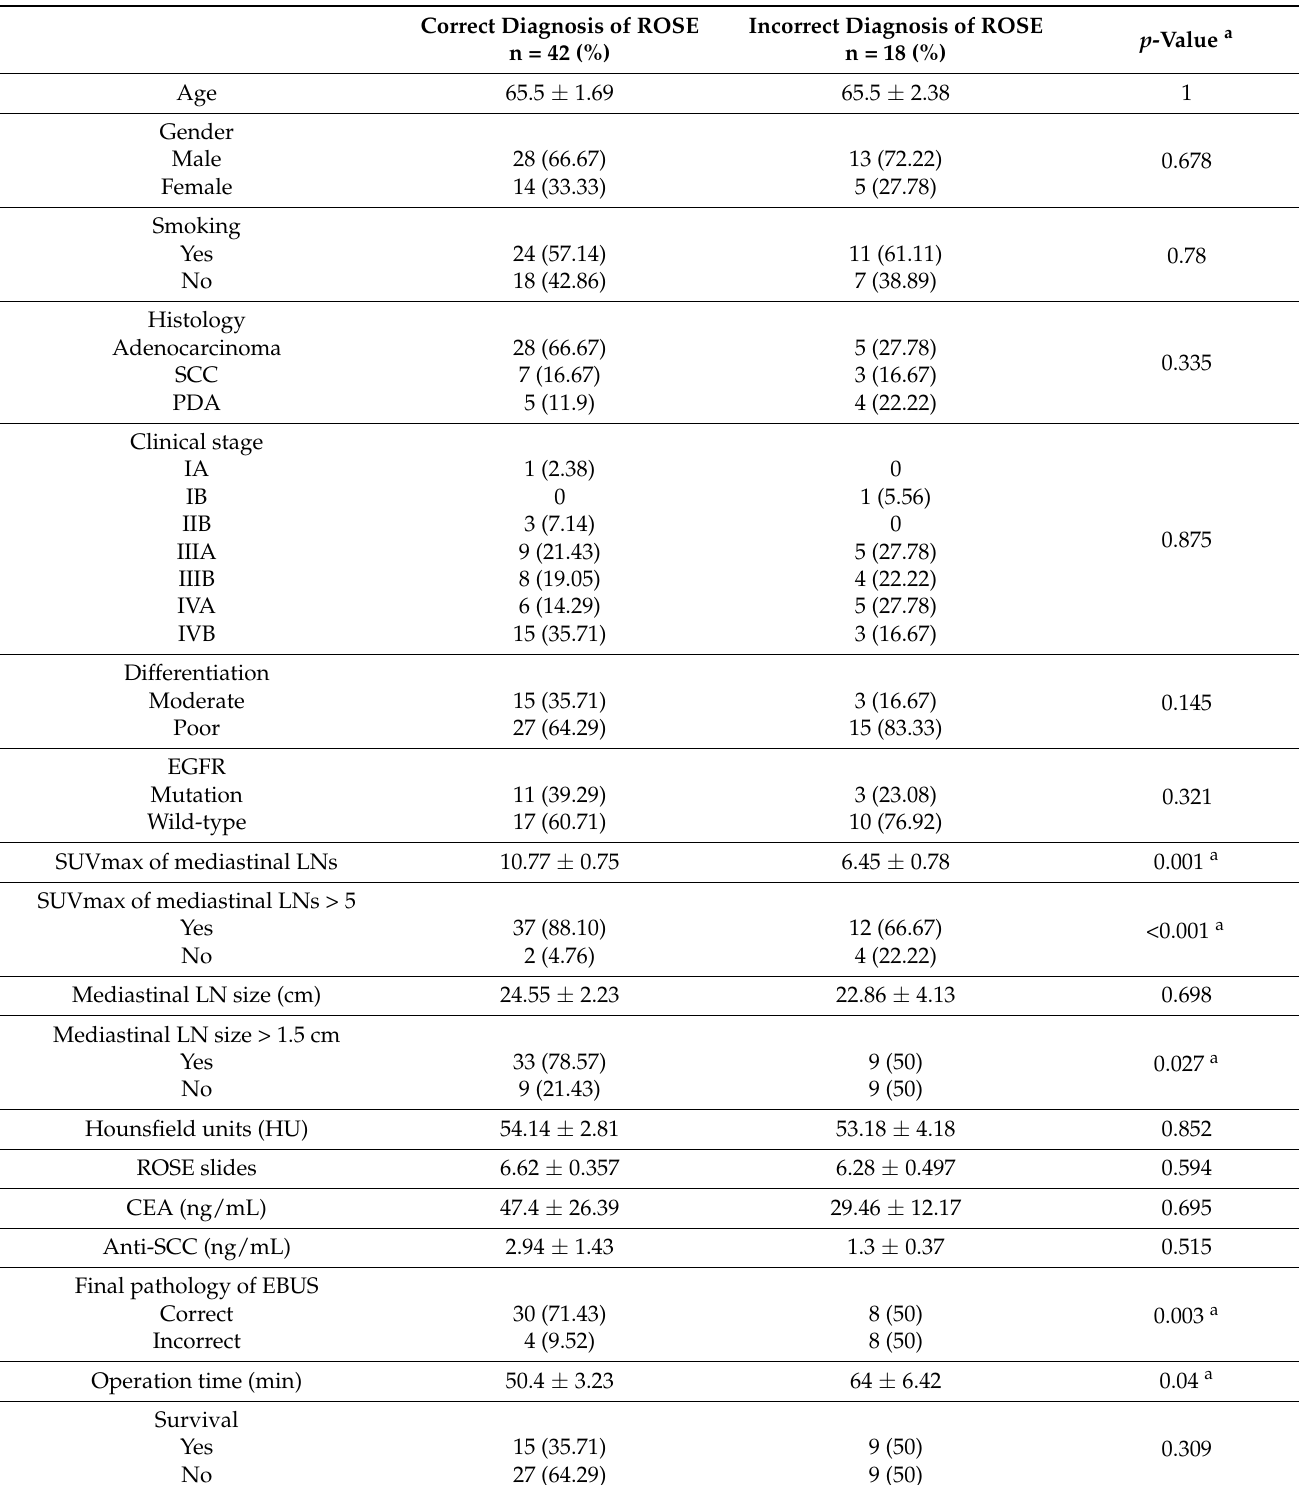
Table 1. Characteristics of non-small cell lung cancer patients with malignant cells involved in mediastinal lymph node by endobronchial ultrasound with trans-bronchial needle biopsy. Correct Diagnosis of